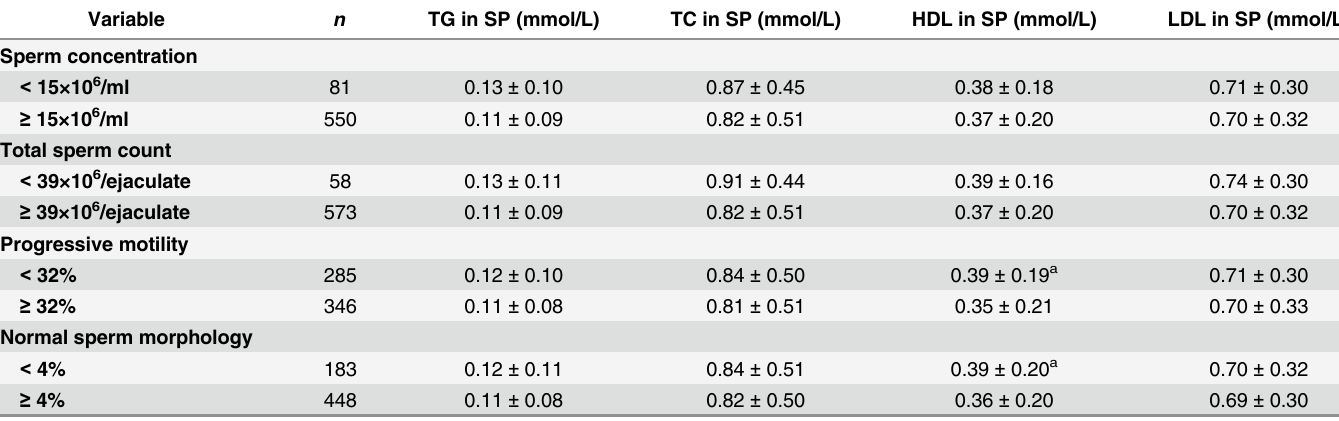
Table 4. Comparisons of lipids levels in seminal plasma based on the dichotomized analyses for semen parameters (mean ± SD). Variable